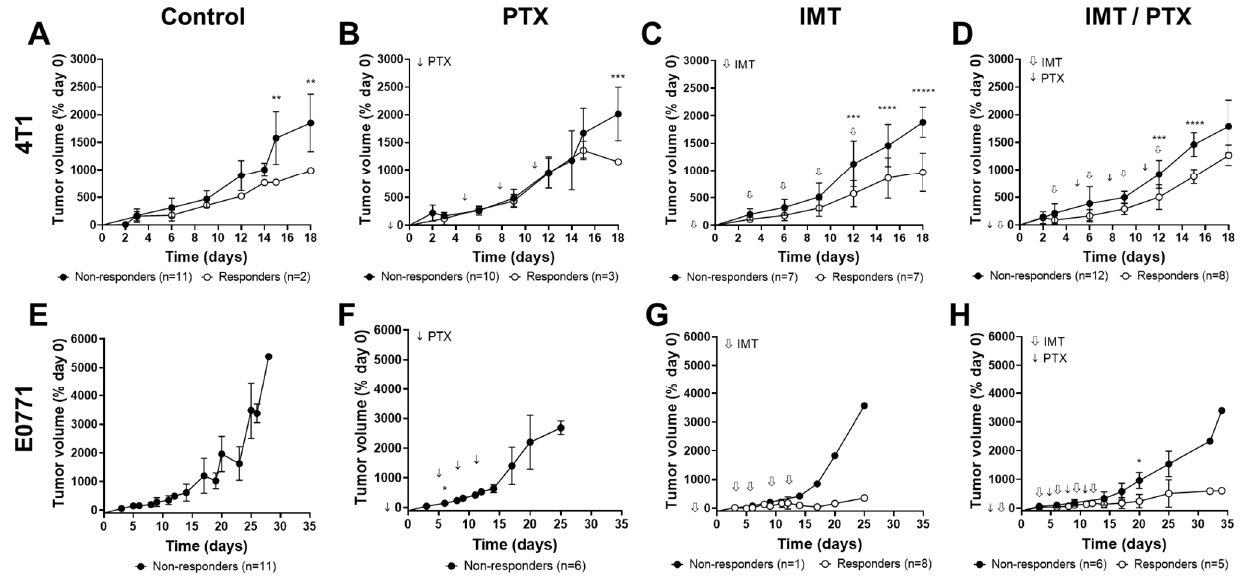
Figure 3. Mice were sorted into non-responder and responder groups based on tumor volume. Mice bearing ( A – D ) 4T1 and ( E – H ) E0771 tumors were separated into non-responder and responder groups for analysis of granzyme B-specific positron emission tomography predictive value. E0771 tumors showed better response to immunotherapy (IMT) ± paclitaxel (PTX) compared to 4T1 tumors. Mean ± SD (* indicates p < 0.05, ** indicates p < 0.01, *** indicates p < 0.001, **** indicates p < 0.0001, ***** indicates p < 0.00001; multiple t -tests).